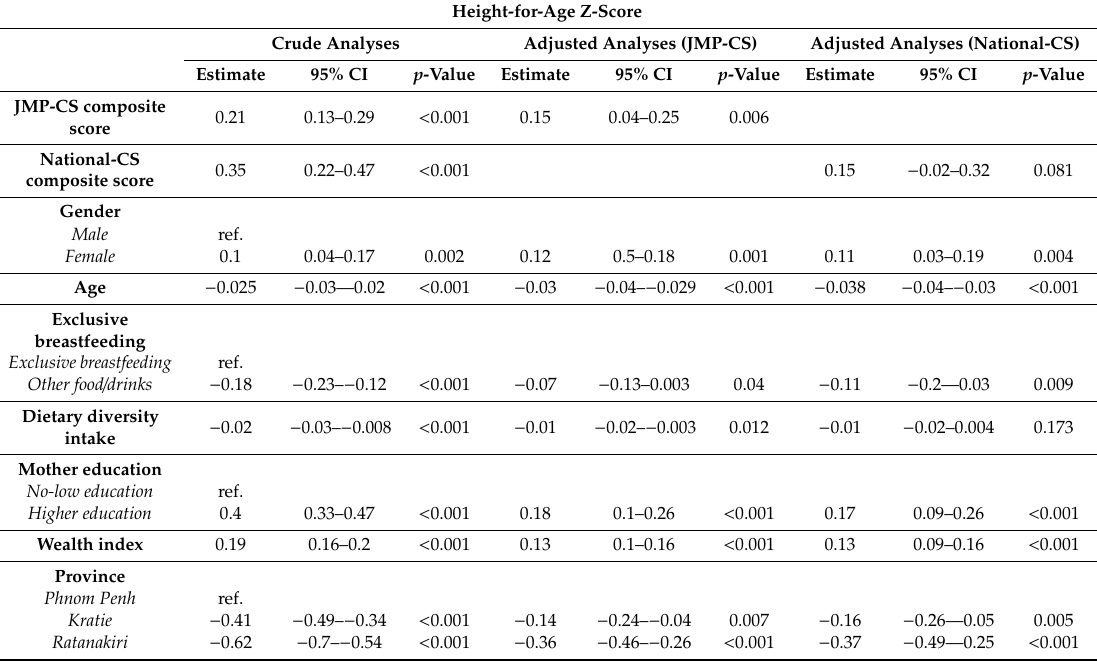
Table 3. JMP-CS and National-CS composite scores, gender, age, exclusive breastfeeding, dietary diversity intake, mother education, wealth index and province in relation to the height-for-age z-scores over